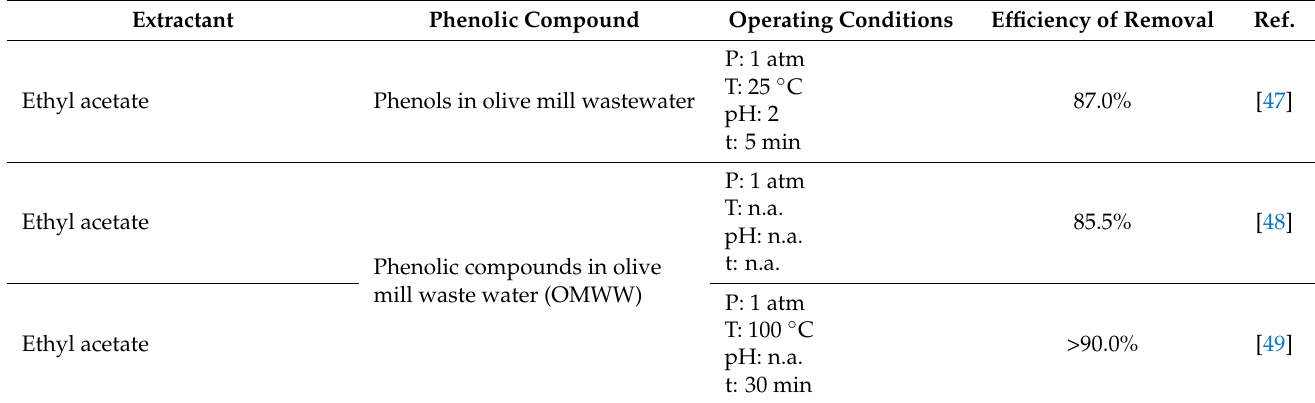
Table 5. Comparison of phenol removal efficiency in wastewater using various extractants via liquid-liquid extraction (LLE) process. Extractant Phenolic Compound Operating Conditions Efficiency of Removal